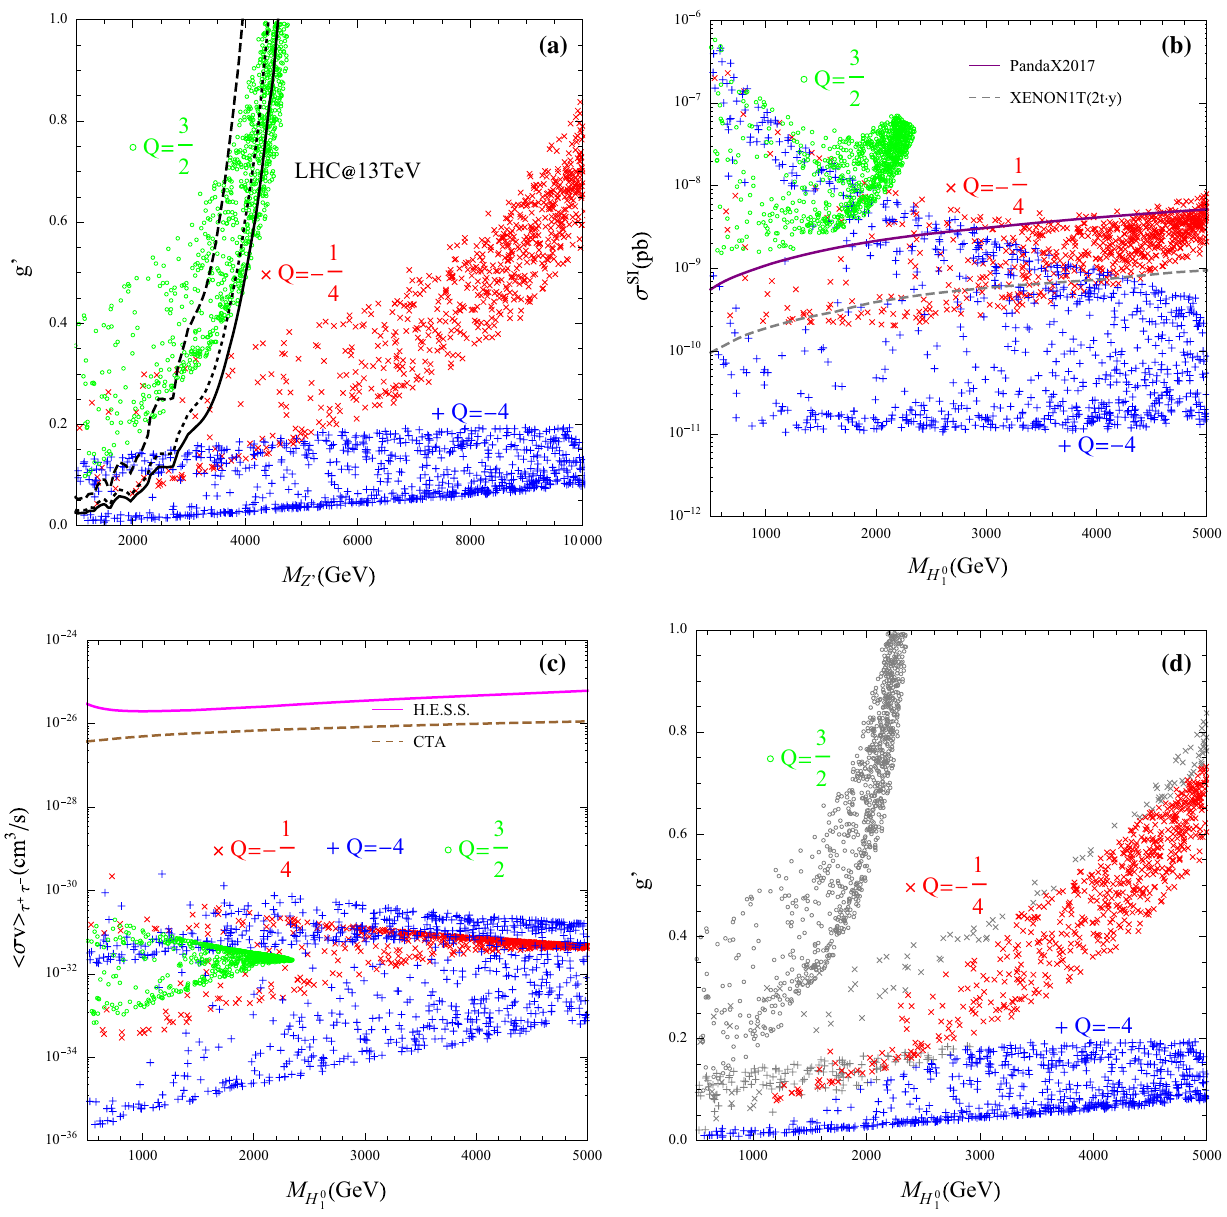
Fig. 14 Scanning results for scalar DM H 0 for relic density in the g (cid:2) - M Z (cid:2) plane. The solid, dotted and dashed lines (from the bottom up) correspond to LHC@13TeV exclusion limits for , 3 Q = − 1 and − 4 respectively. b Spin-independent cross section as 4 2